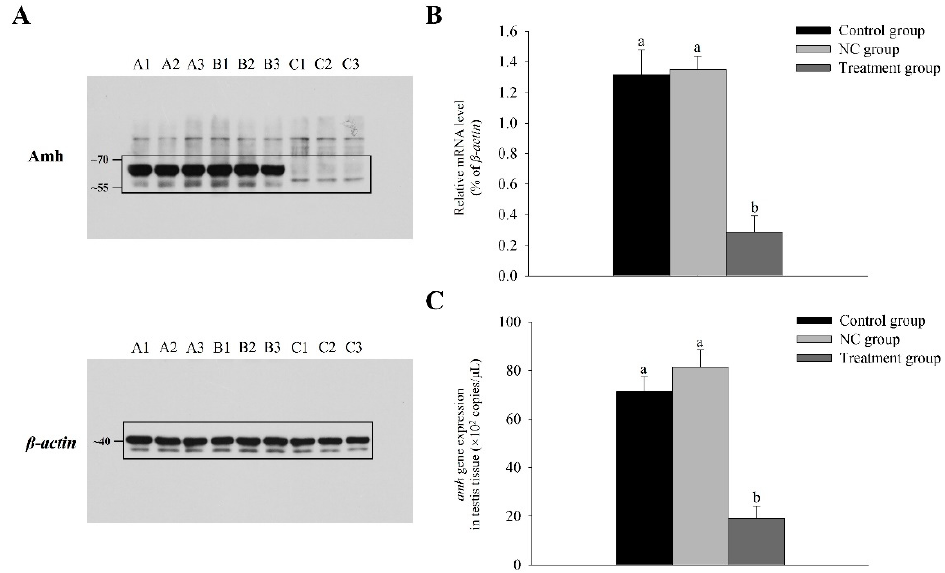
Figure 2. Down-regulation of amh down-regulated the expression of Amh protein and the mRNA expression level of amh . ( A ) Representative images of expression levels of Amh protein in testis tissues of control and treatment groups: A1–A3, control; B1–B3, negative control (NC); C1–C3, treatment. β -actin was an internal parameter in each group; ( B ) Transcript levels of amh in testis tissues of each group (mean ± SE, n = 12 replicates). Identification of amh mRNA levels in treatment, control, and negative control (NC) groups as determined by qRT-PCR; ( C ) Absolute quantitative expression levels of amh in testis tissues of each group (mean ± SE, n = 12 replicates). Identification of amh mRNA levels in treatment, control, and negative control (NC) groups as determined by qRT-PCR. Different lowercase letters indicate significant differences ( p <